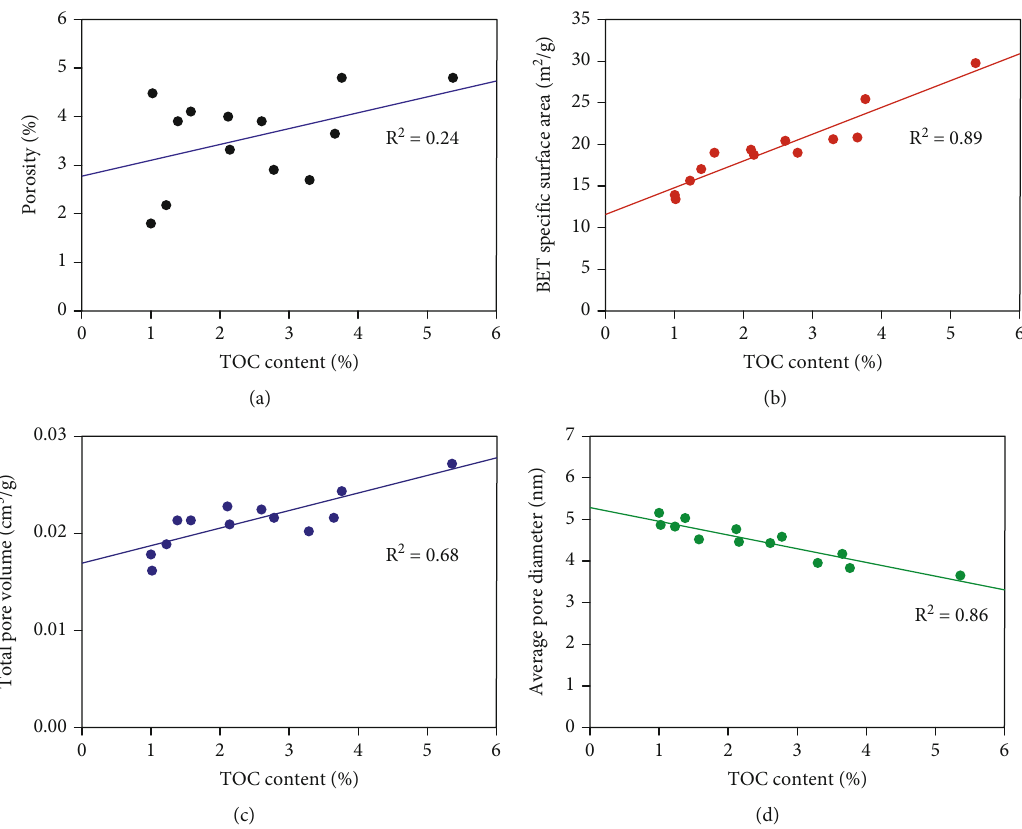
Figure 8: The relationship between TOC content and (a) porosity, (b) BET-speci fi c surface area, (c) total pore volume, and (d) average pore diameter of the studied gas shales using FE-SEM